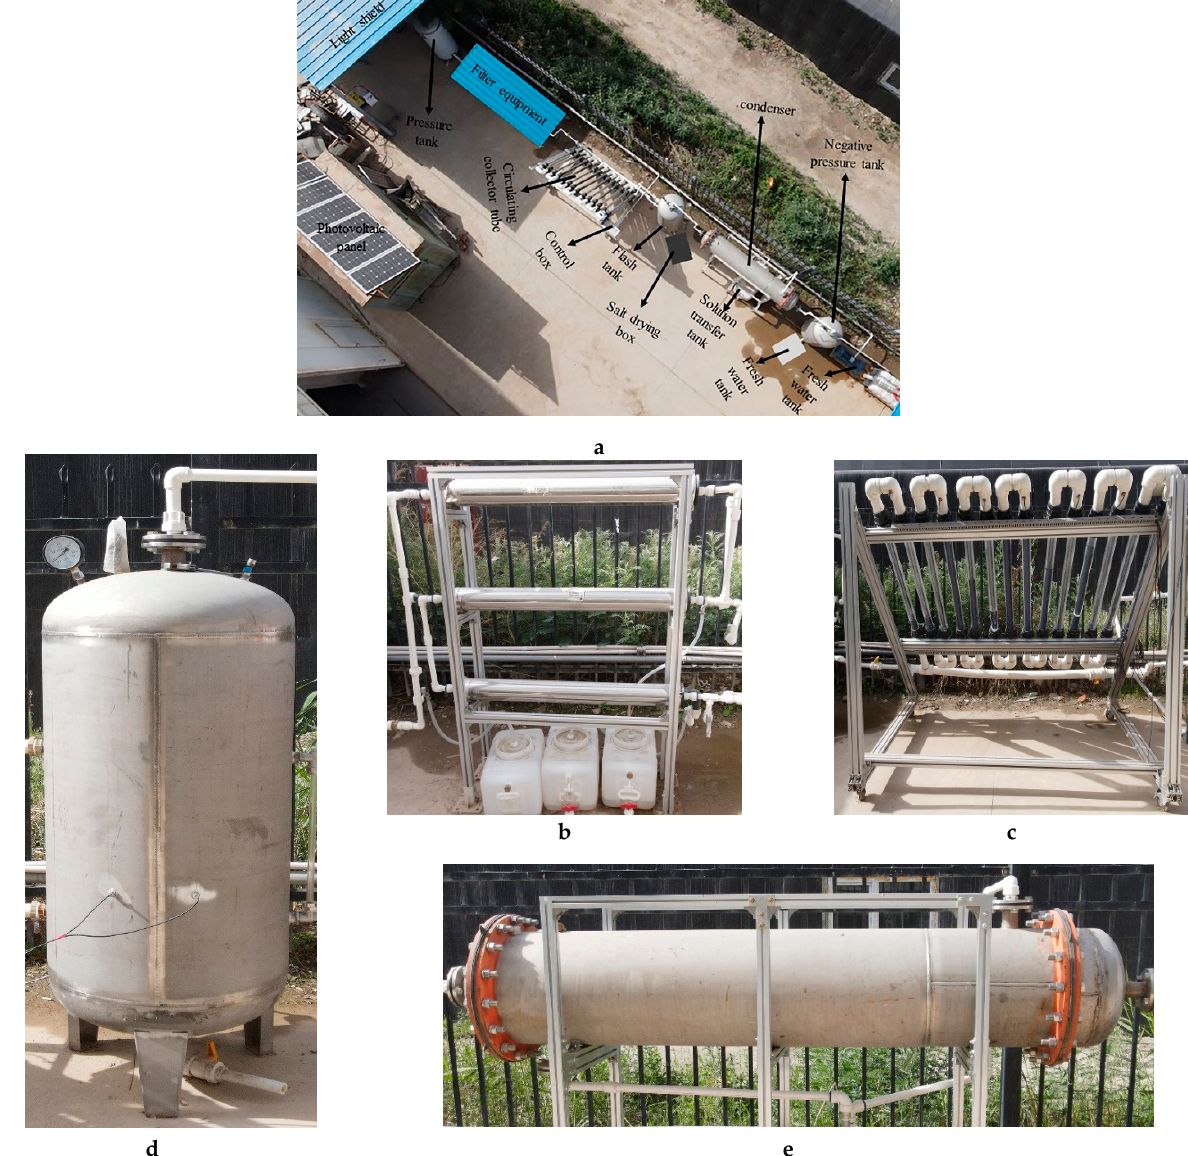
Figure 6. Installation environment of farmland saline alkaline water separation and desalination device: ( a ) general drawing of farmland saline alkaline water separation and desalination unit; ( b ) NF-RO device; ( c ) circulating solar collector tube; ( d ) flash tank; ( e ) shell-and-tube circulating